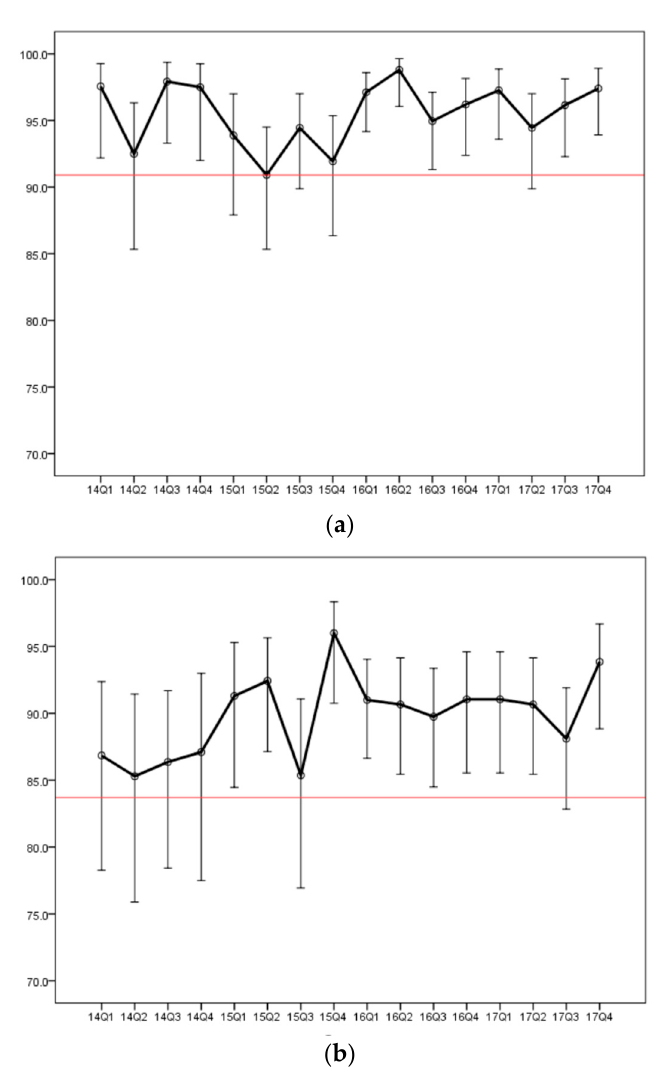
Figure 3. Observed positive predictive values (%) for each quarter. ( a ) trisomy 21; ( b ) trisomy 13, trisomy 18 and monosomy-X combined. True positives are based on combined evidence from follow-up with genetic testing, ultrasound findings, or fetal loss. Error bars denote 80% confidence intervals. Shorter bars at later quarters reflect larger numbers of cases used to determine PPV. Red lines denote lower boundary values (90.9% for T21 and 83.7% for T18, T13, and MX) and are based on the mean minus two standard deviations. All PPVs exceed the lower boundary values. Upper boundary values are not shown.